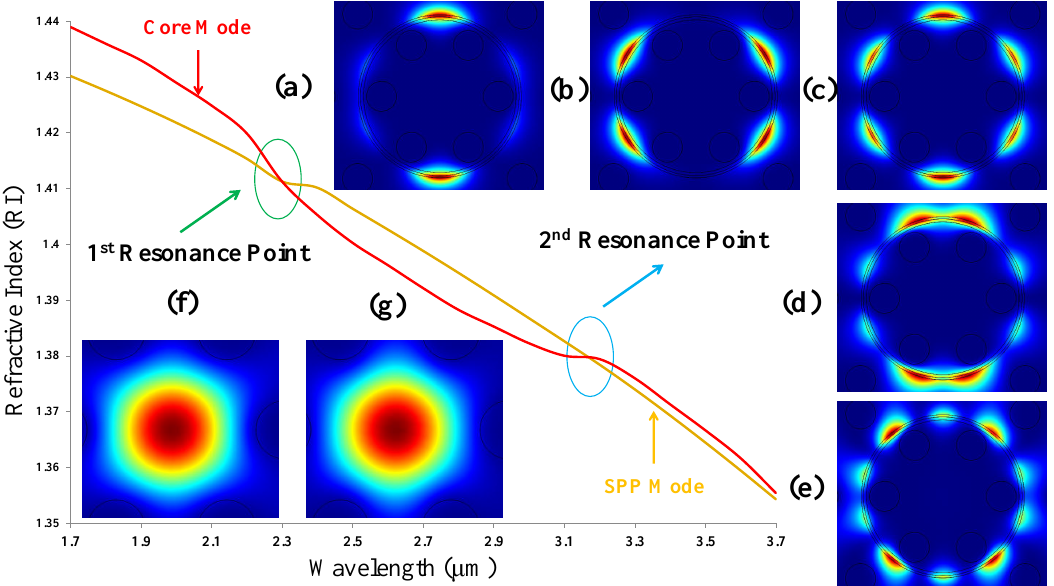
Figure 2. The representation resonance peak points for analyte 1.33 with SPP modes ( a – e ) first–fifth SPP modes; fundamental modes ( f ) X-polarization and ( g )